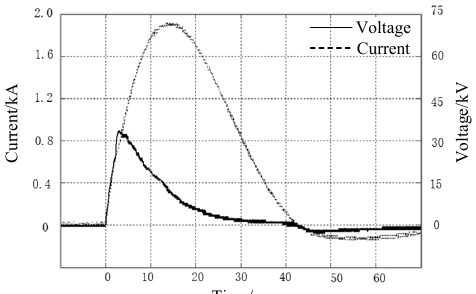
Figure 14. Current and voltage waveform of modified soil with the SAP content of 0.25% when injected into the impulse current.